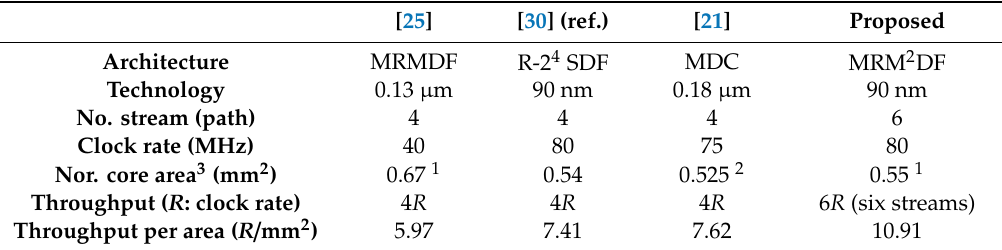
Table 3. Performance evaluation and comparison based on 128-point FFT